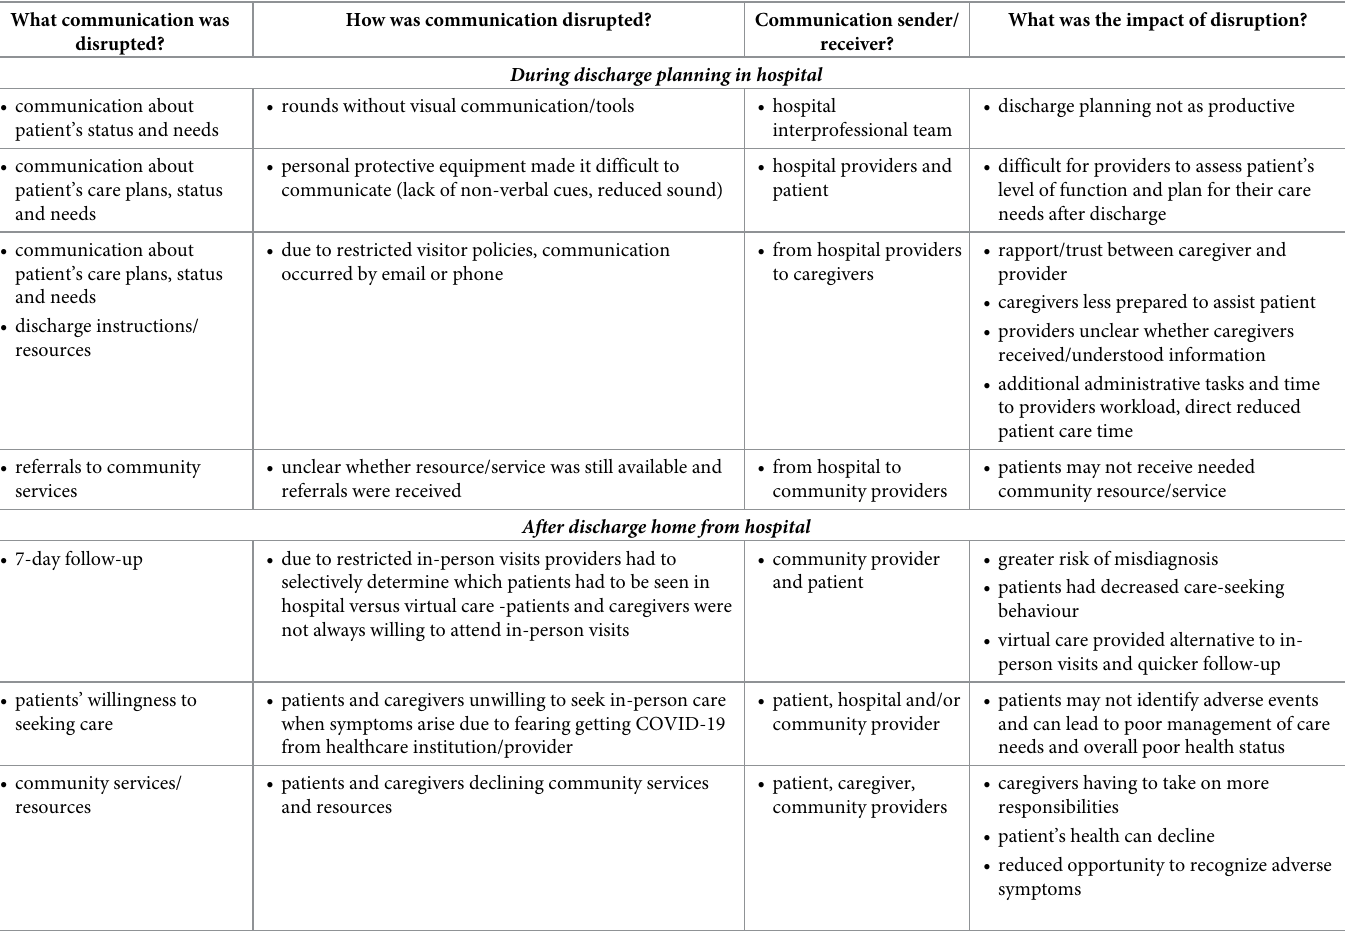
Table 2. Transition-related communication disruptions during the COVID-19